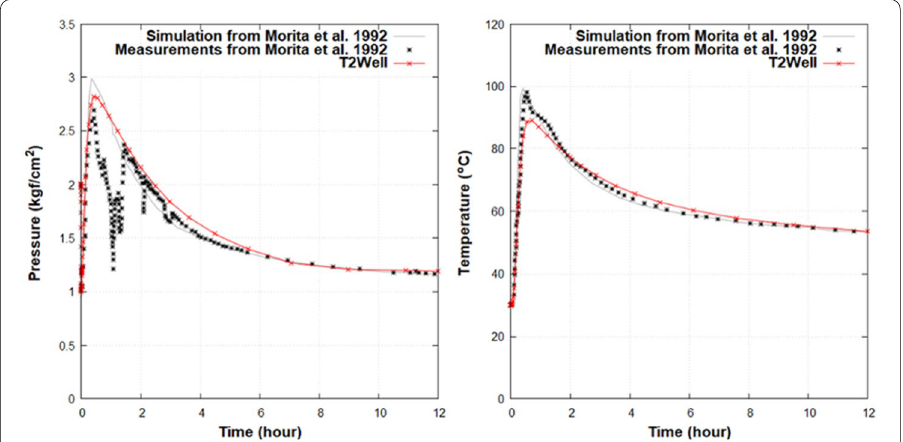
Fig. 3 Left—transient pressure simulation with T2Well compared to measurements from Morita et al. (1992). Right—transient temperature simulation with T2Well compared to measurements from Morita et al.